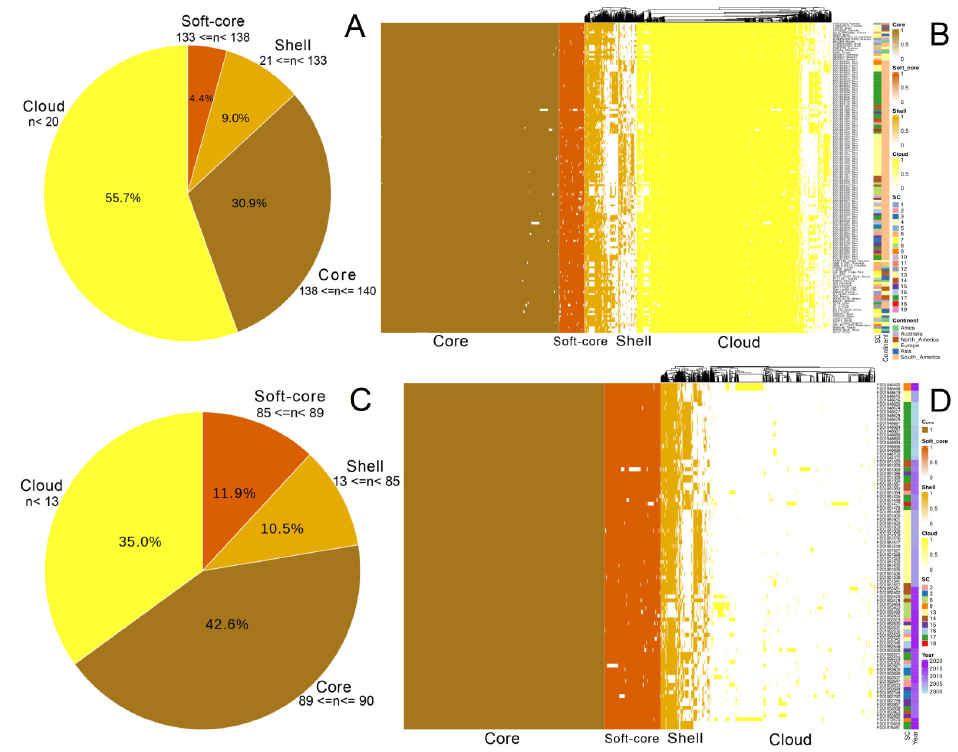
Figure 2. Pan-genome analyses of S. Typhimurium isolates. ( A , C ), Pie charts showing the proportion of repertoire genes in the core, soft-core, shell, and cloud of the pangenome of the global ( n = 140) and Peruvian S. Typhimurium isolates ( n = 90). ( B , D ), Gene presence-absence matrix shows the gene distribution in each genome. Heatmap legends on the right of panels ( B , D ) indicate the cluster sequence to which each sample belongs. The accessory genome of 69.1% and 57.4% presents a high diversity of gene content distinguished by sequence clusters (lineages) for Peruvian and global sam- ples.